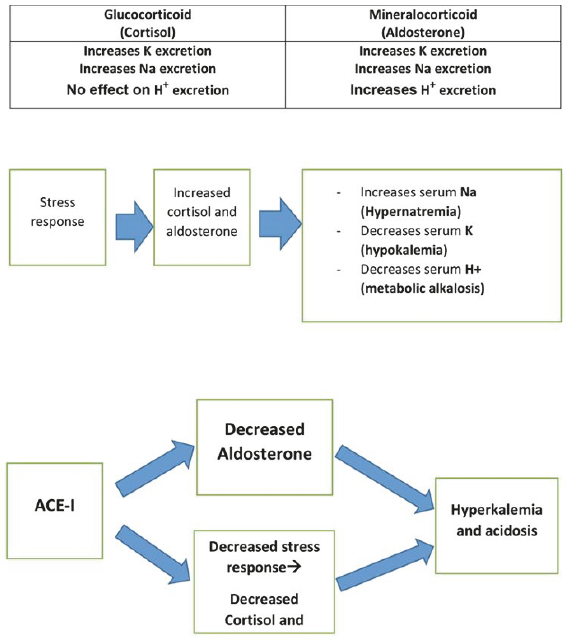
Figure 1: Pathophysiology of ACE-I induced hyperkalaemia and acidosis. ACE-I: Angiotensin Converting Enzyme